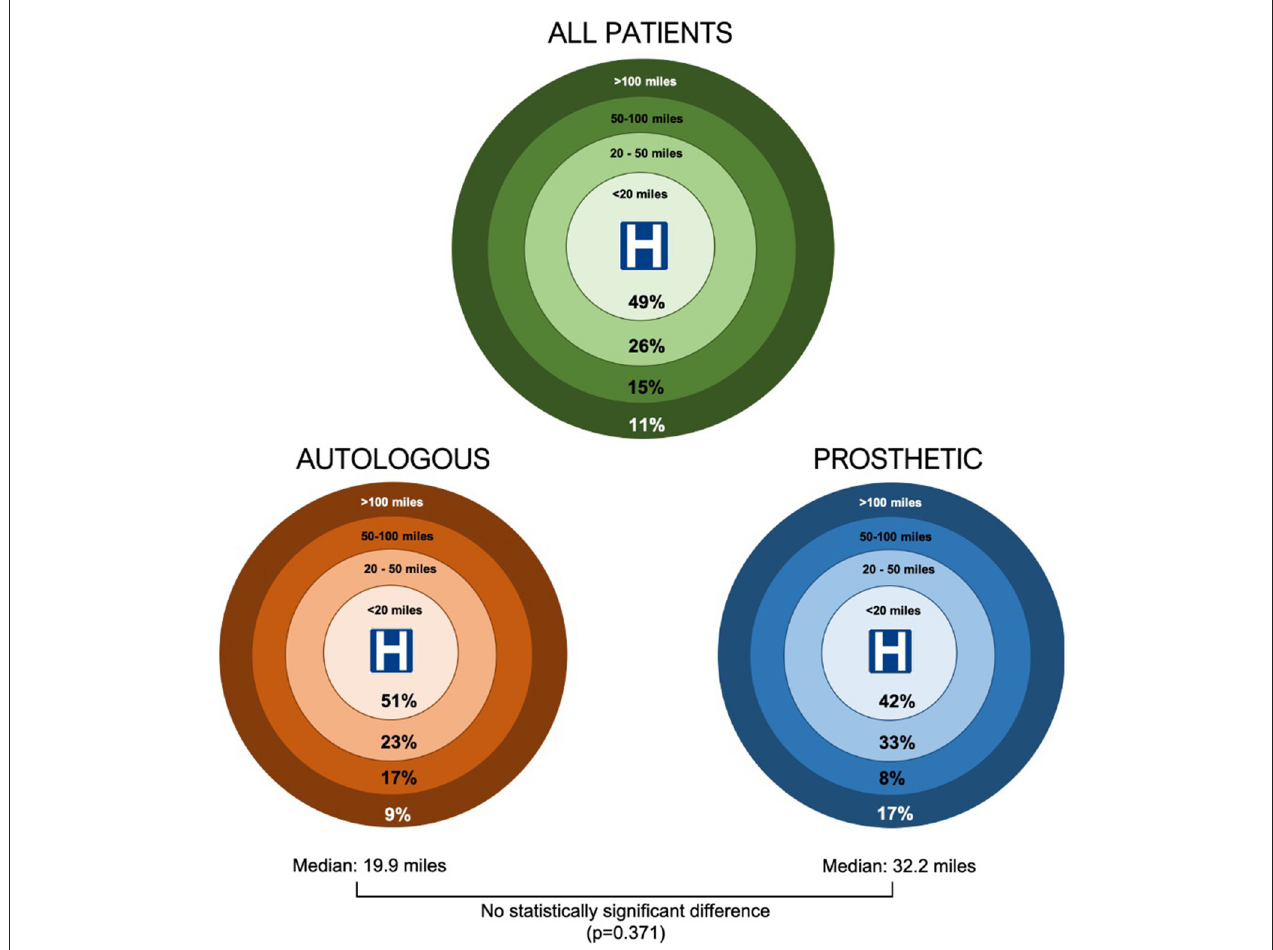
FIGURE 3 | Geodesic distances traveled by patients undergoing microtia reconstructive surgery in Wales.